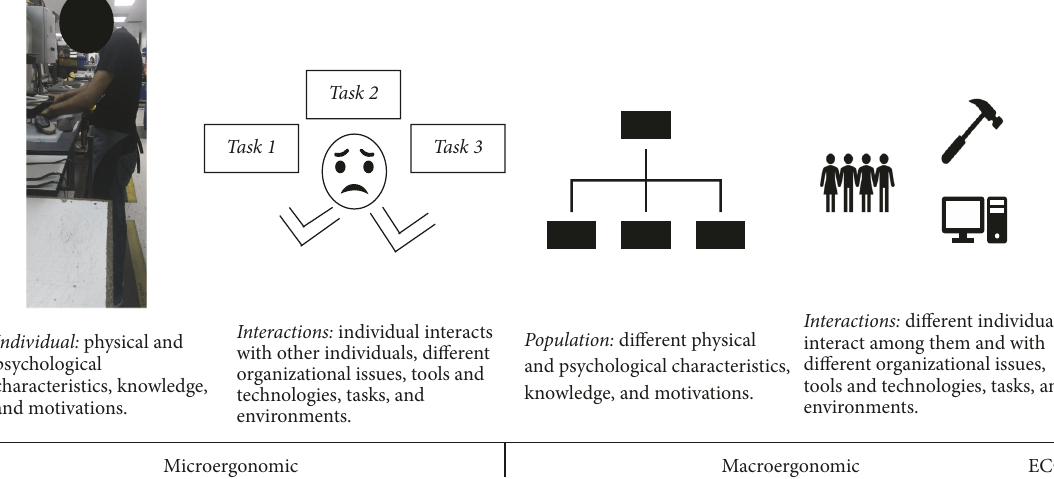
Figure 1: Ergonomic compatibility complexity at micro- and macroergonomic levels.